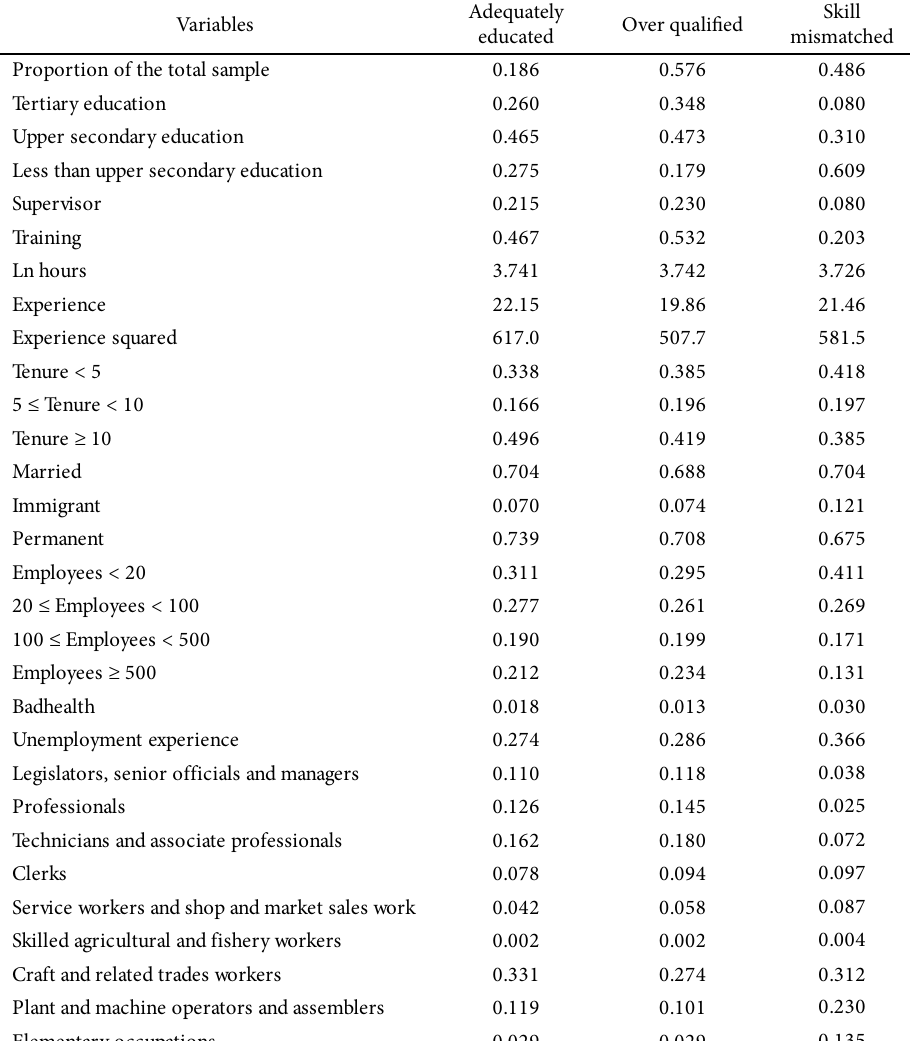
Table 3. Descriptive statistics by mismatch status. Pooled